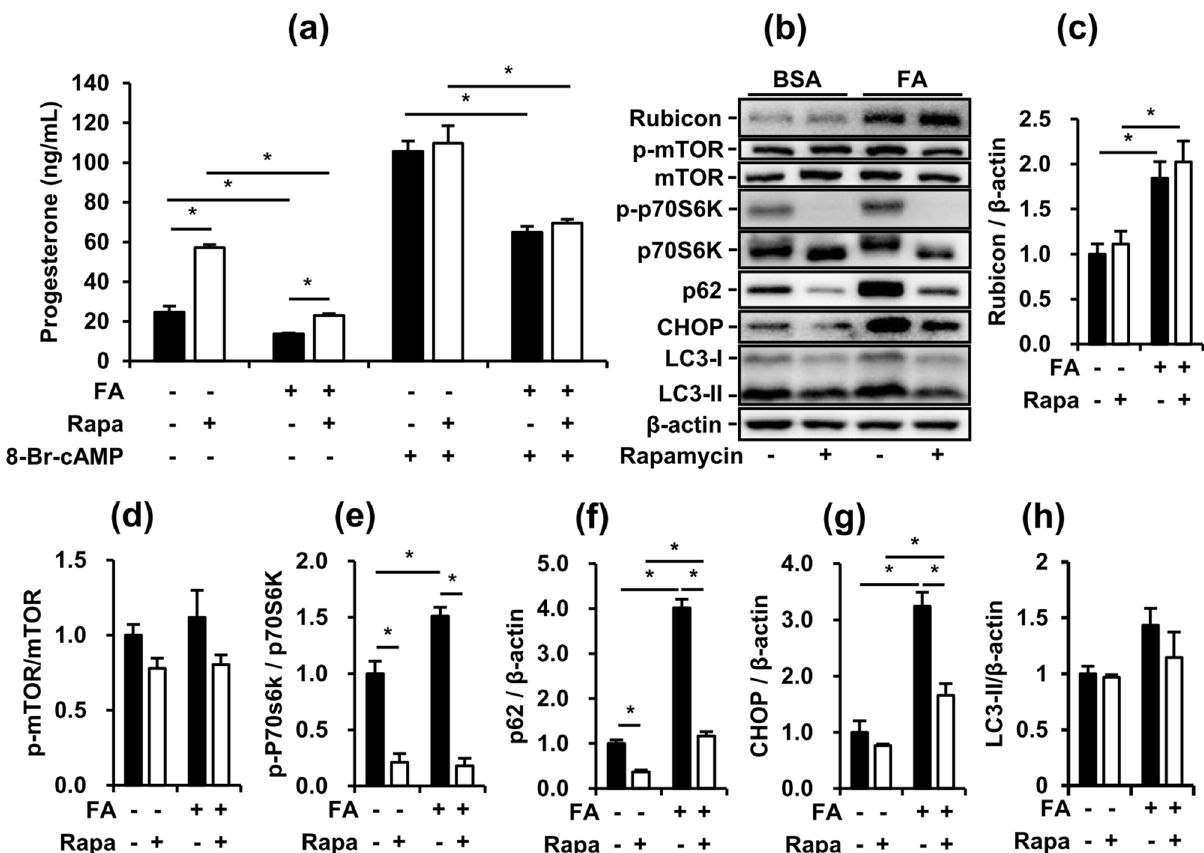
Figure 5. Rapamycin partially restores FA-suppressed basal steroidogenesis of MA-10 cells. After treatment with FA for 48 h and co-treatment with 10 nM rapamycin in the last 24 h, MA-10 cells were treated with or without 50 µM 8-Br-cAMP for 4 additional hours to induce steroidogenesis. ( a ) Progesterone levels in conditioned medium from the assigned groups of MA-10 cells. ( b ) Representative blots of autophagy and ER stress markers in cultured MA-10 cells are shown. ( c ), ( d ), ( e ), ( f ), ( g ), ( h ) Quantifications normalized by β-actin are shown as means ± SEM (n = 3). *P <